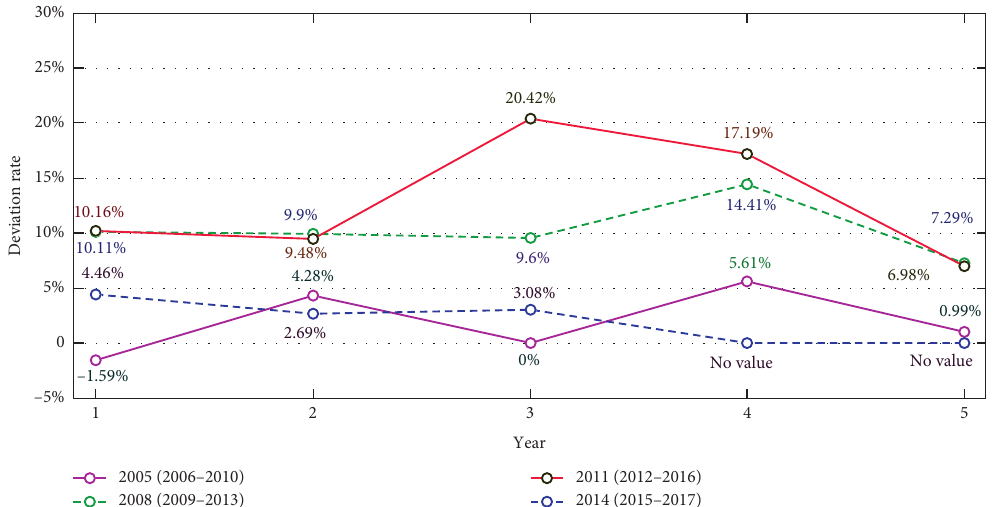
Figure 7: How the difference occurs in the process of prediction by PDP models (dotted line to solid line). The changes of five-year time interval (2006–2010) deviation rates (2005 as the input); the changes of five-year (2009–2013) deviation rates (2008 as the input); the changes of five-year (2012–2016) deviation rates (2011 as the input); the changes of five-year (2015–2017) deviation rates (2014 as the input); the deviation trajectory generated by the prediction errors. Overlapping prediction parts, i.e., 2009–2010 {input 2005 (5.61% and 0.99%), 2008 (10.11% and 9.9%)}, 2012–2013 {input 2008 (14.41% and 6.98%), 2011 (10.11% and 9.48%)}, and 2015–2016{input 2011 (17.19% and 6.98%), 2014 (4.46% and 2.69%)}, indicate the input data of different years can predict different results for the same year. In this graph, “No value” means no deviation rate due to the lack of statistical data in